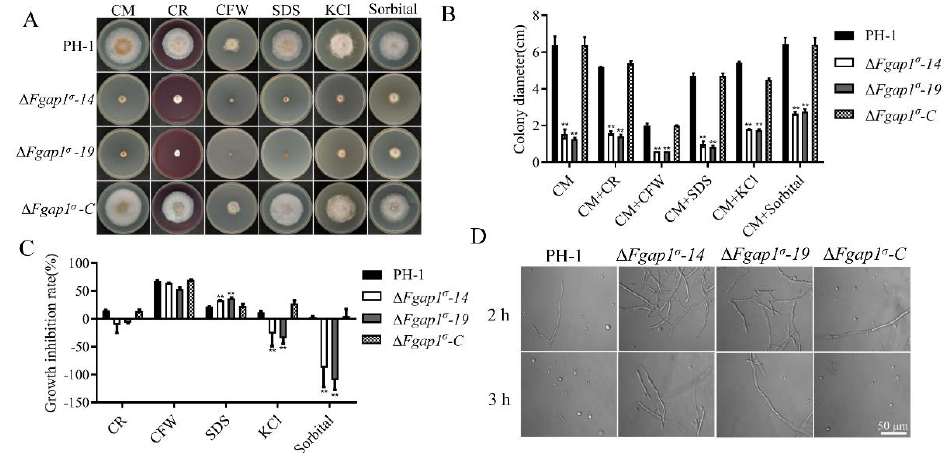
Figure 5. Deletion of FgAP1 σ resulted in cell wall integrity and osmotic pressure defects. ( A ) The PH- 1, ΔFgap1 σ , and ΔFgap1σ -C strains were incubated on CM plates supplemented with Congo red (CR, 200 μg/mL), calcofluor white (CFW, 200 μg/mL), SDS (0.01 %), sorbitol (1 M), and KCl (1 M) at 28 °C for 3 days. ( B ) Colony diameter of the indicated strains under cell wall and osmotic stresses. Level of significance was measured using an unpaired t -test (** p < 0.01). ( C ) Growth inhibition rate of the strains due to cell wall and osmotic stresses induced by the indicated agents. Level of significance was measured using an unpaired t -test (** p < 0.01). ( D ) Protoplast releasing potential of the PH- 1 and ΔFgap1 σ mutants after treatment with cell-wall-degrading enzymes for 2 h and 3 h. Bar = 50 μm.